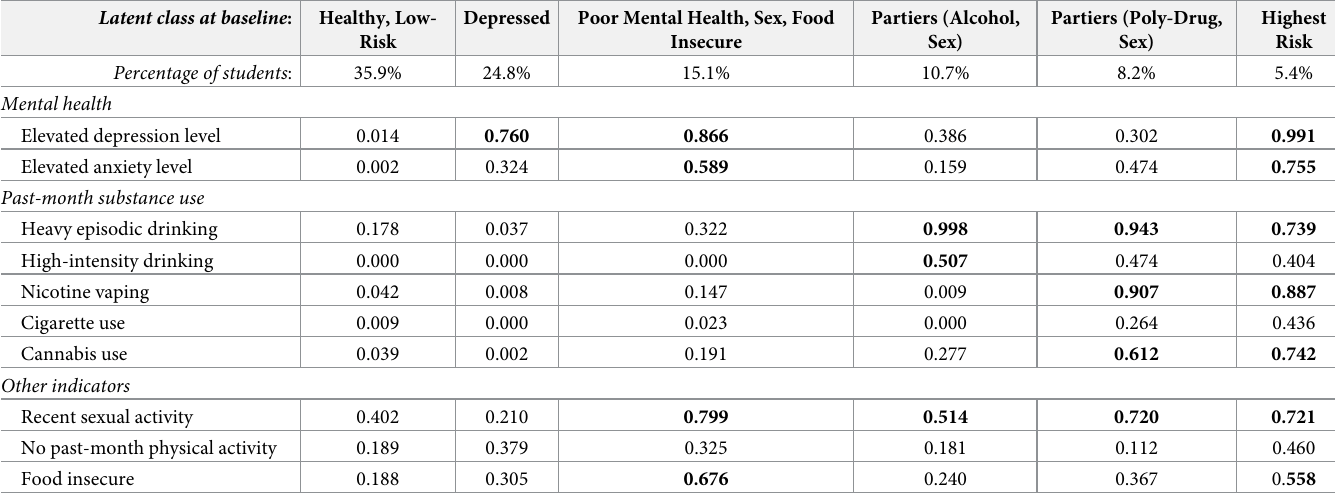
Parameter estimates for the six-class model at baseline are shown in Table 3, ordered by class prevalence. Class 1 (35.9% of students) was labeled “Healthy, Low-Risk” as this class was unlikely to report any of the 10 indicators of problematic health and well-being. Class 2 (24.8%) was characterized by a very high rate of elevated depression symptoms but low rates of endorsing each of the other indicators of well-being; thus, we labeled this class “Depressed.” Table 3. Six-class model of college student health and well-being at